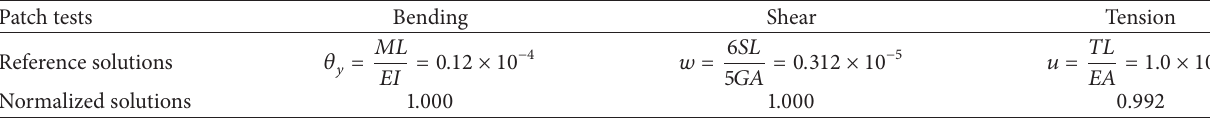
Table 1: Results of patch test under bending, shear, and